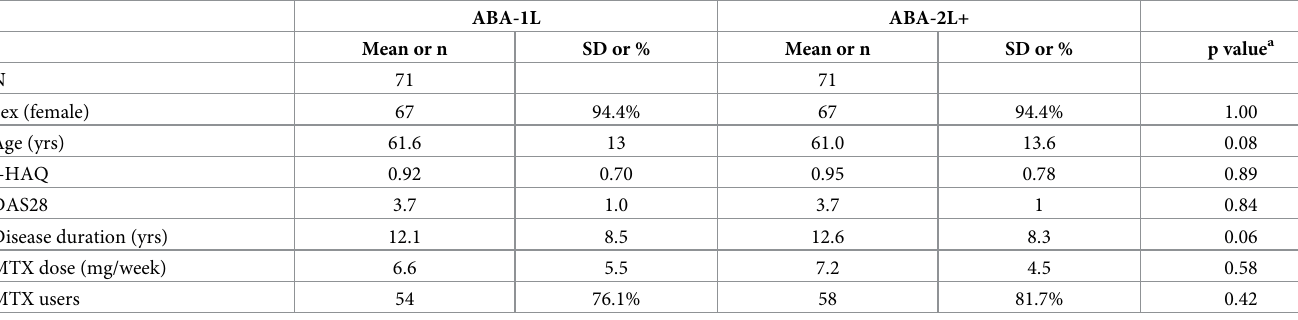
Table 2. ABA-1L vs. ABA-2L+: Patient characteristics of matched